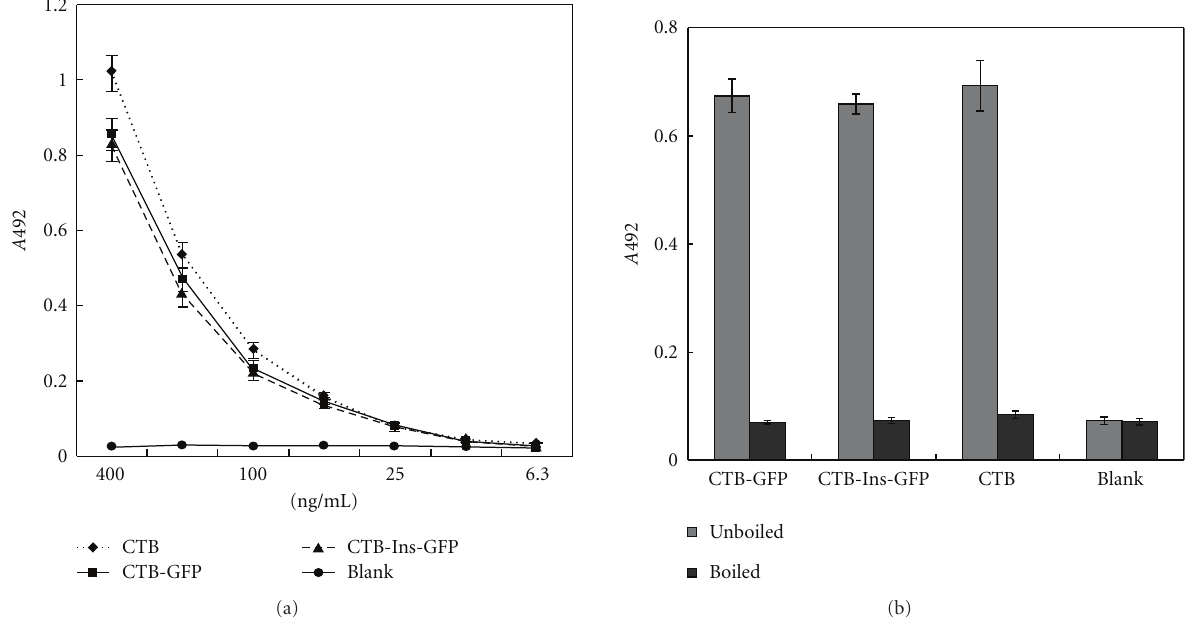
Figure 3: GM1 a ffi nity assay. (a) Reactivity of the CTB-Ins-GFP protein with the GM1 ganglioside and a native bacterial CTB control. (b) Boiling induced pentamer dissociation into monomers. Approximately equal amounts of the three di ff erent samples indicated were used to measure A492 signal levels. Data represent the mean A492 values ± SD of each sample. The experiment was repeated